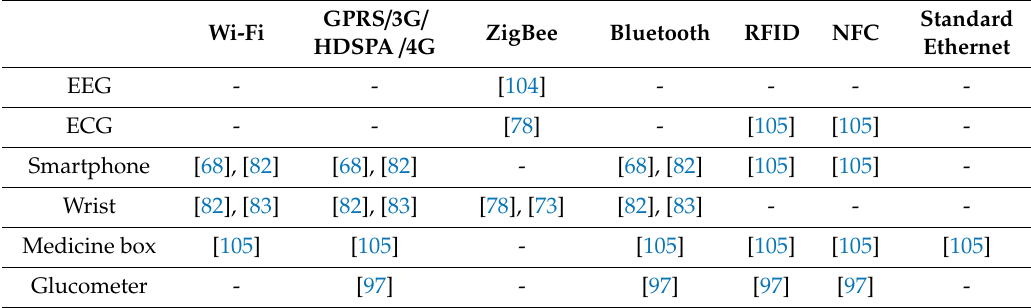
Table 3. Communication technologies used for the design of healthcare